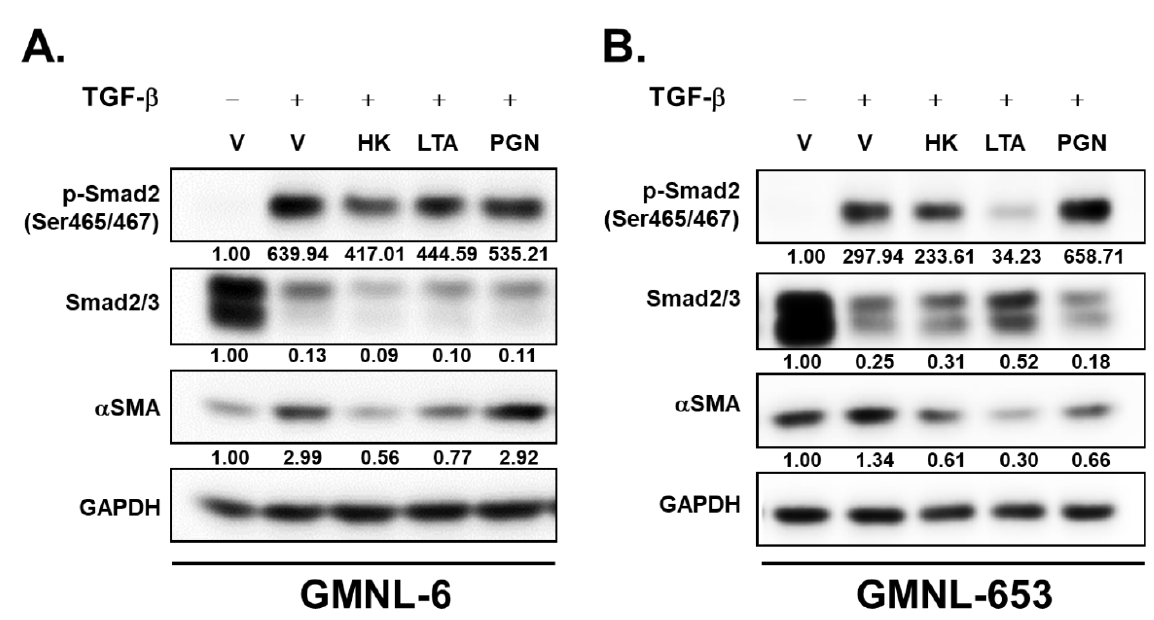
Figure 6. The treatment of lipoteichoic acid (LTA) caused similar benefits to those of heat-killed GMNL-6/GMNL-653 in TGF- β -induced fibrosis of Hs68 cells. The Hs68 cells were treated with 20 ng/mL TGF- β alone or in a combination of heat-killed (HK) Lactobacillus bacteria suspension at 1 × 10 9 cells/mL, or the derived LTA at 50 µ g/mL or peptidoglycan (PGN) at 50 µ g/mL for 24 h followed by harvesting the total cellular proteins. The expressions of Smad2 phosphorylation and α SMA were determined by western blot. ( A ) GMNL-6, ( B ) GMNL-653. The inserted numbers indicated relative expression level in comparison to the vehicle (V) and without TGF- β treatment.